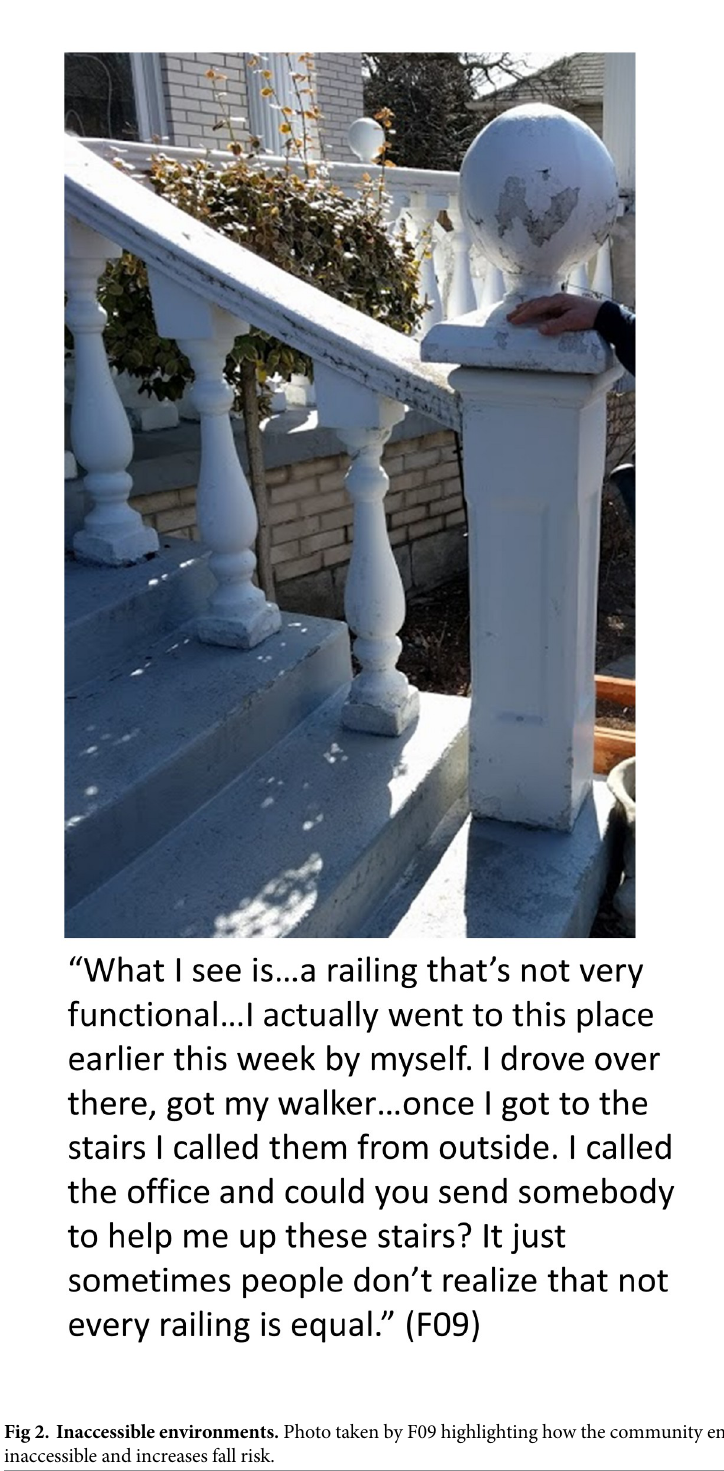
Fig 2. Inaccessible environments. Photo taken by F09 highlighting how the community environment is often inaccessible and increases fall risk.